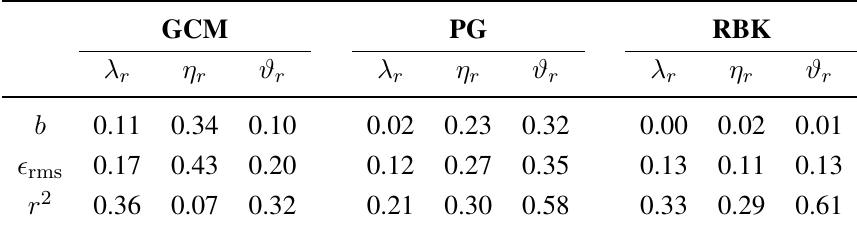
Table 2. Equilibrium predictor error